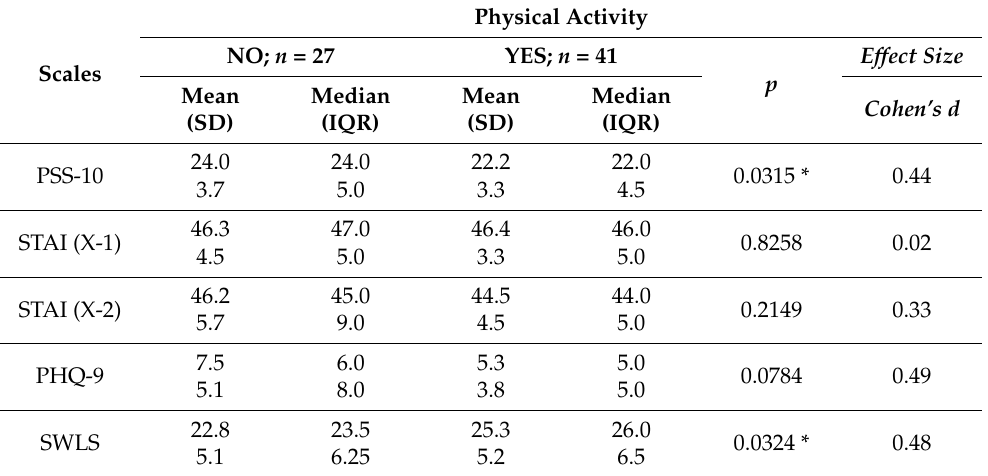
Table 3. Results of selected scales according to declared physical activity in the whole study group, (Mann–Whitney U